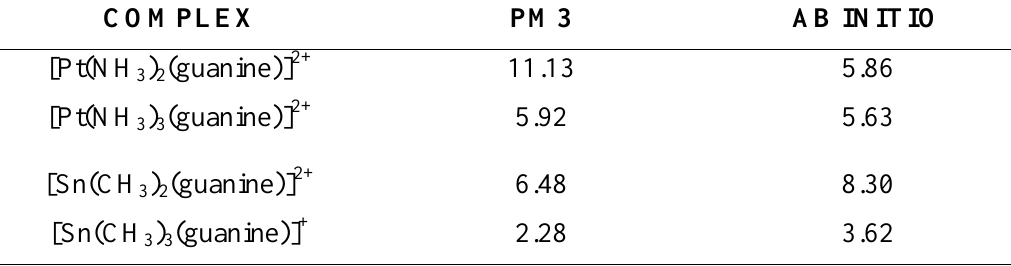
Table 2. Binding energies [eV] for some model complexes of tin-DNA fragments